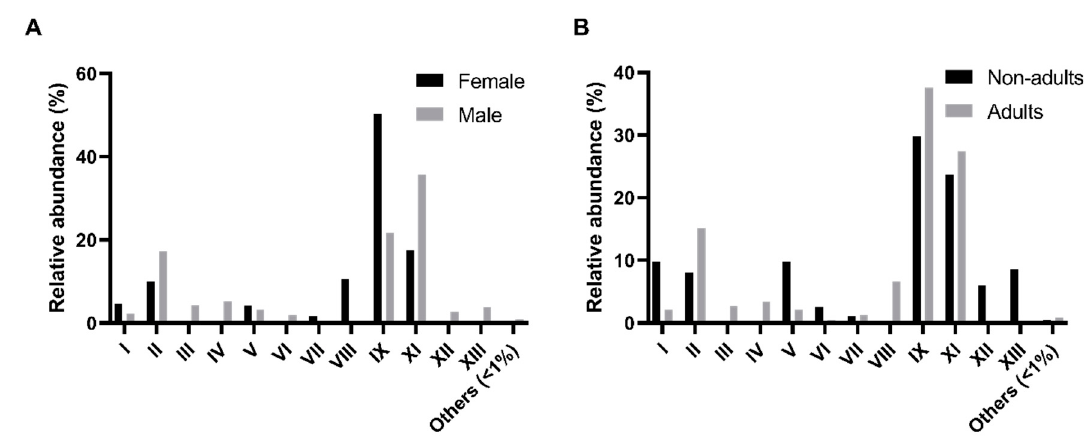
Figure 1. Comparison of the morpho-physiological types detected in the intestinal microbiota of the Egyptian mongoose specimens across sex and age classes. ( A ) Relative abundance in female and male individuals; ( B ) Relative abundance in nonadult and adult individuals.